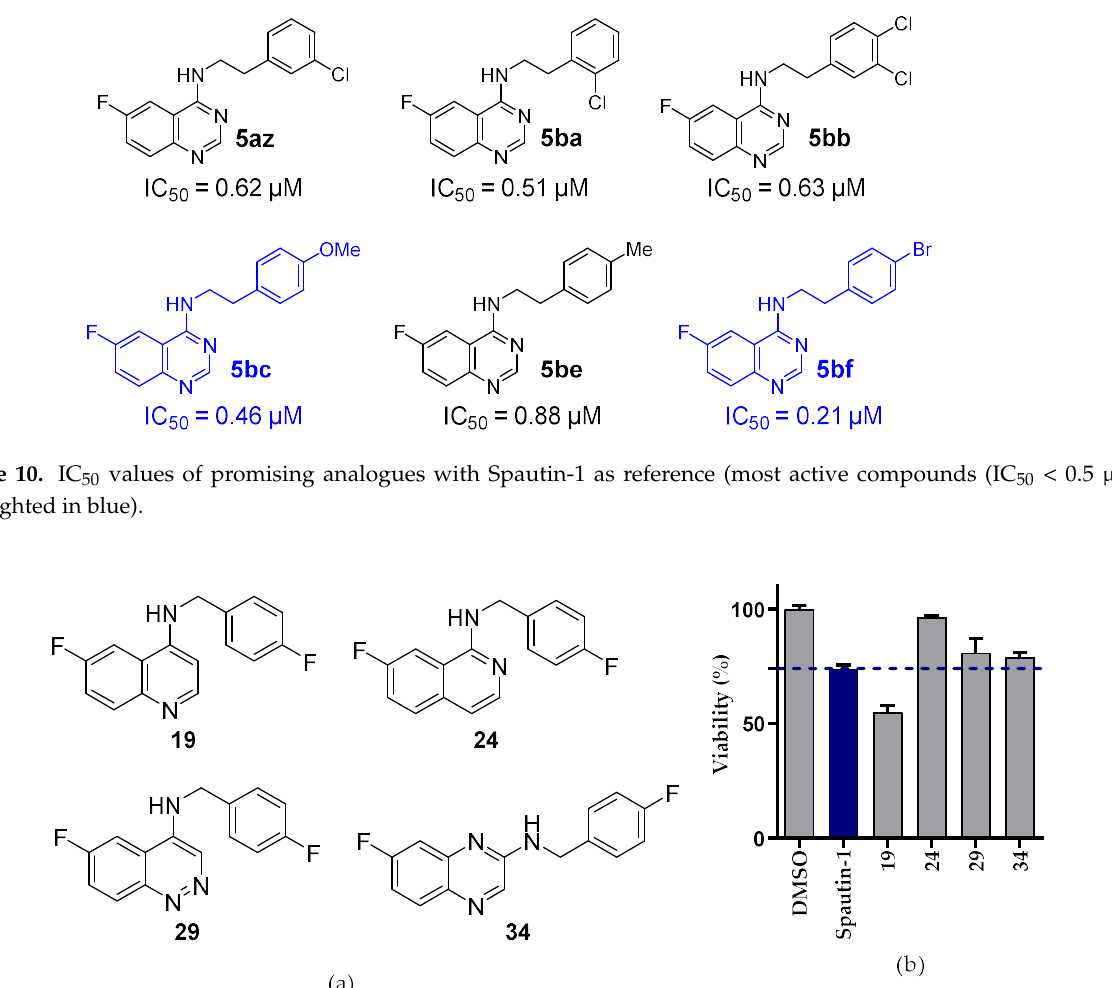
Figure 10. IC 50 values of promising analogues with Spautin-1 as reference (most active compounds (IC 50 < 0.5 µM) high- lighted in blue).